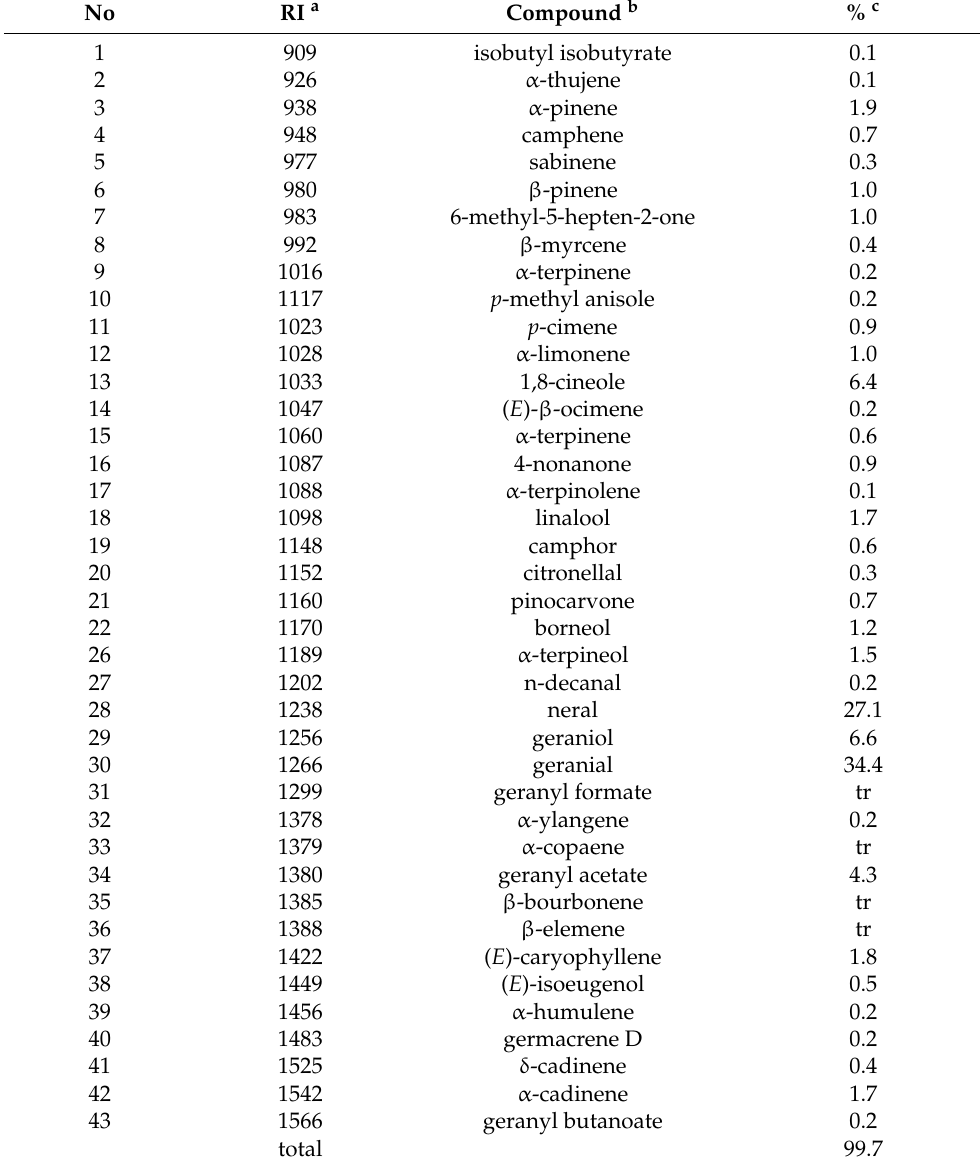
Table 1. Chemical composition of lemongrass essential